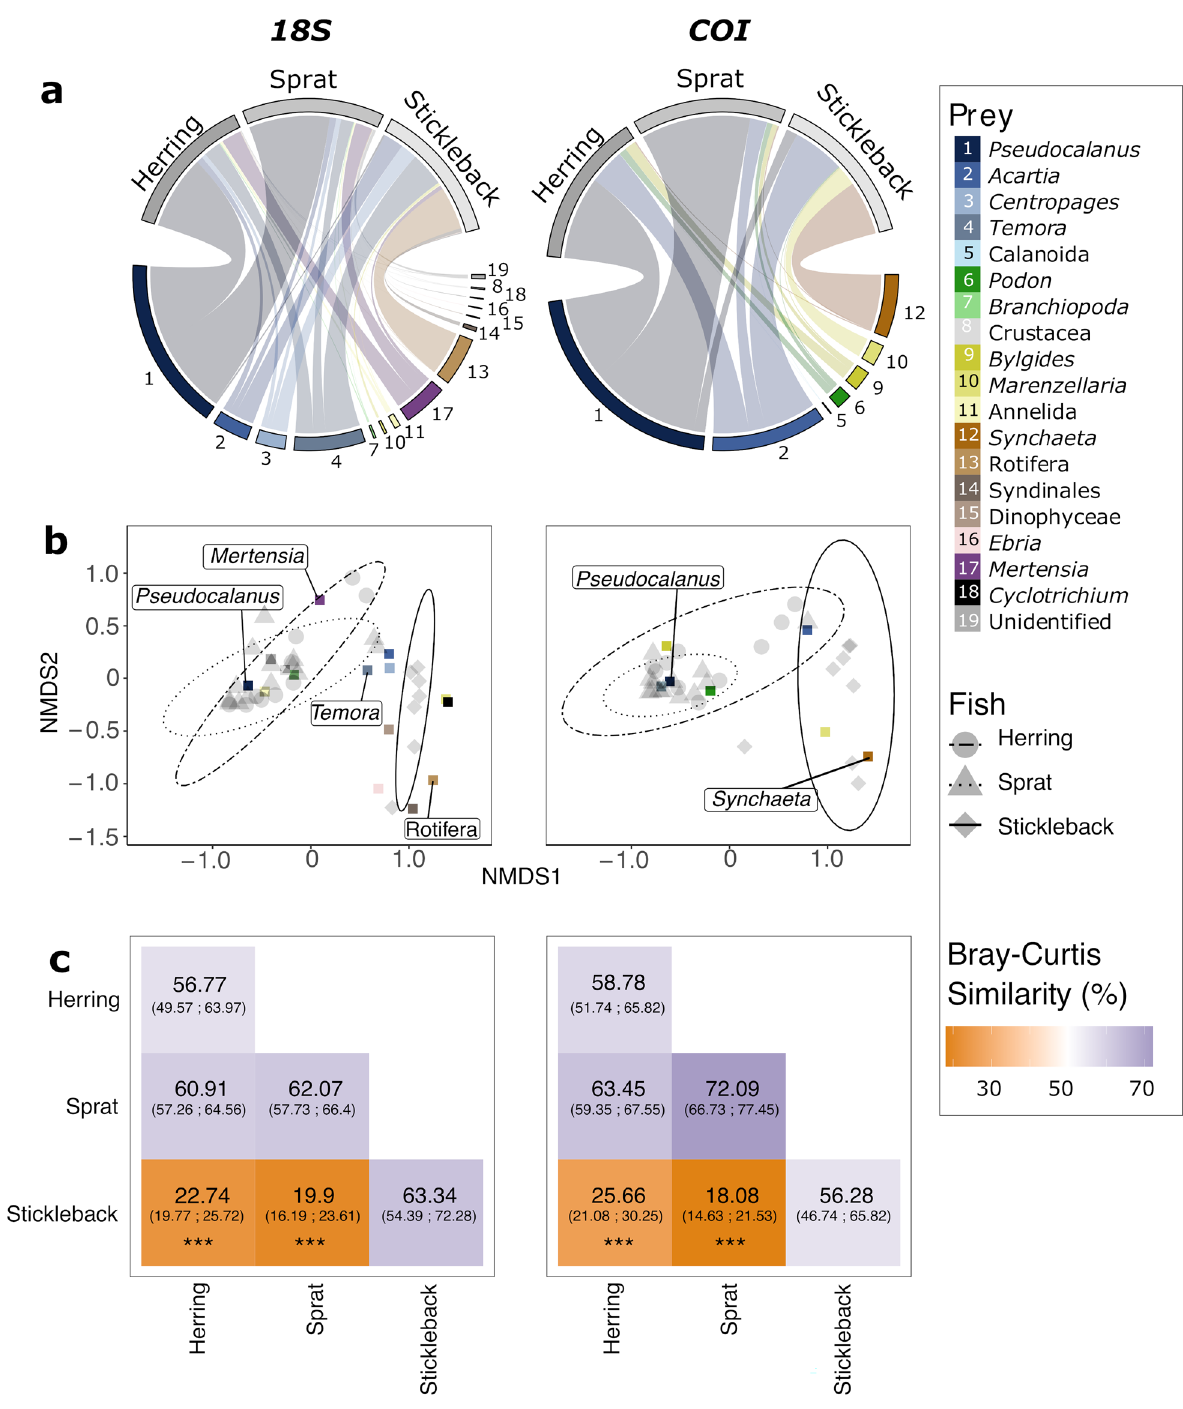
Figure 2. ( a ) Prevalent prey (lower) of the planktivorous fish herring ( Clupea harrengus ), sprat ( Sprattus sprattus ) and stickleback ( Gasterosteus aculeatus ) (upper) based on their gut-content analysis using DNA sequences in the southern Baltic Sea. The thickness of the links is proportional to the relative 18S rRNA (left) and COI (right) read abundance. ( b ) Nonparametric multidimensional scaling (NMDS) plot of fish prey composition based on Bray–Curtis distance of 18S rRNA (left) and COI (right) gut content sequences. The prey species are represented with the coloured squares and the prey contributing to the most difference between fish species is shown with their names. Ellipses following the t-distribution of the NMDS scores are shown for each fish species. ( c ) Bray–Curtis similarity Index (BCI) in percent with the 95% confidence interval in the bracket between and across (diagonal) each fish species. A low BCI indicates low niche overlap. The output of the pairwise permANOVA is shown with the asterisks (*** = P <